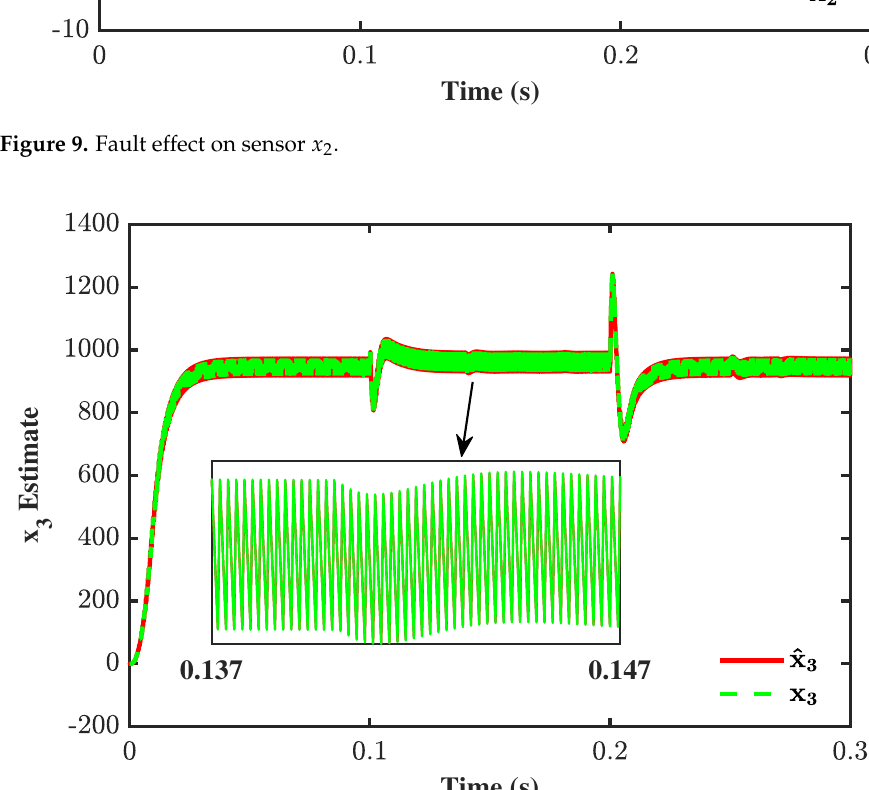
Figure 10. Fault effect on sensor x 3